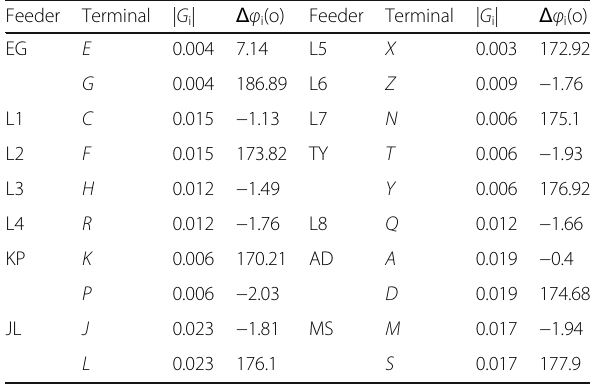
Table 4 Pre-fault measured admittance results before fault occurs Feeder Terminal | G i |